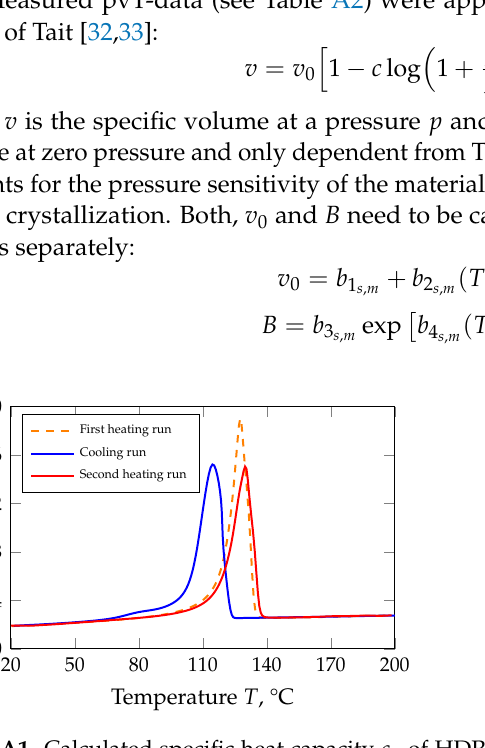
Figure A1. Calculated specific heat capacity c p of HDPE at a heating rate of 10 K min − 1 and at a cooling rate of 20 K min − 1